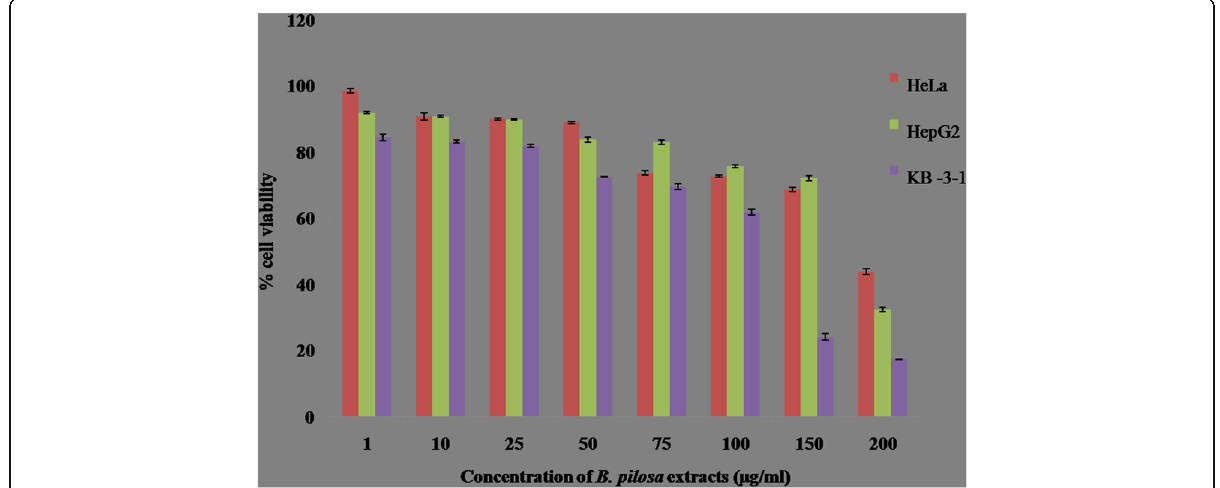
Fig. 3 Effect of methanol leaves extract of B. pilosa on tested cancer cell lines. Bar represents the means ± SD of triplicate